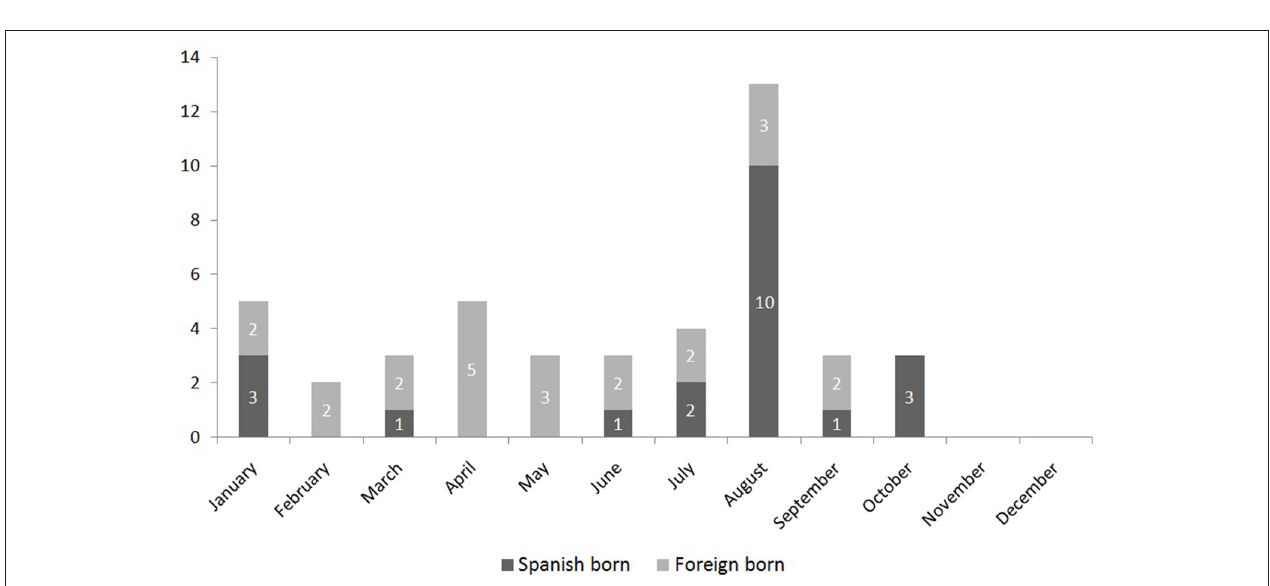
FIGURE 3 | Monthly distribution of the 44 imported cases of Zika virus in Barcelona according to country of birth (Spanish born or foreign born). Period: January–December 2016.